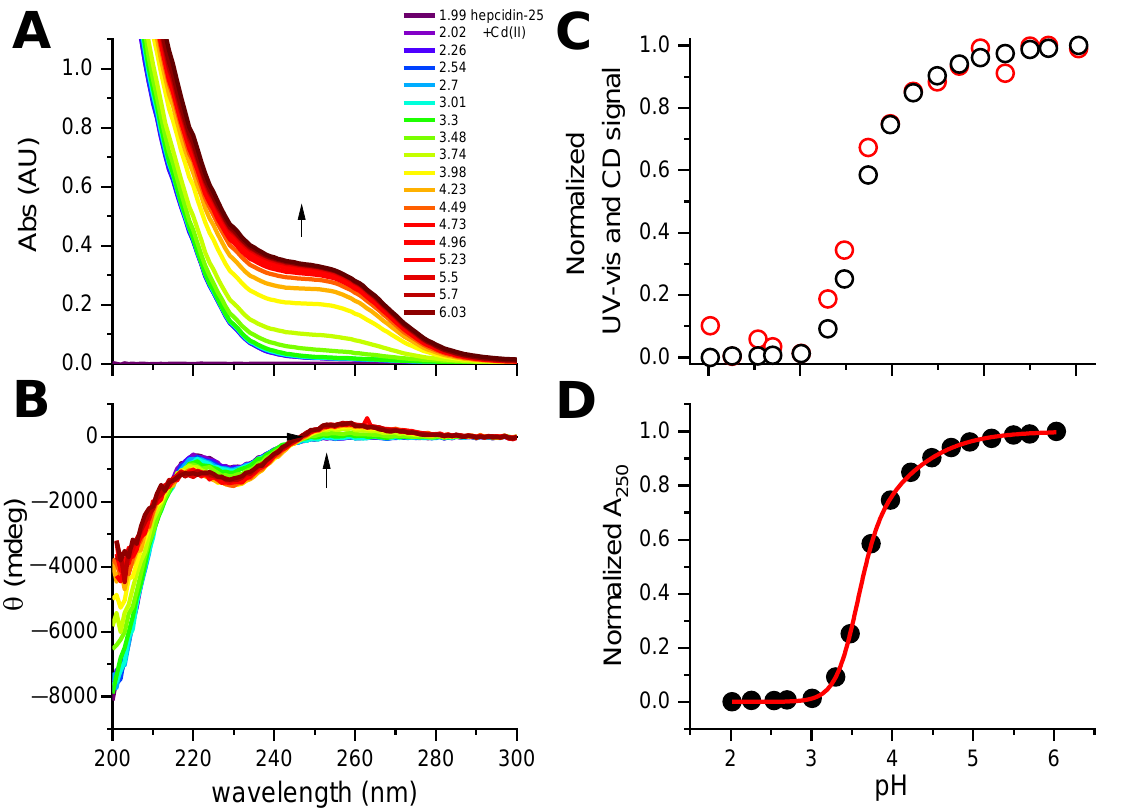
Figure 2. The pH-metric titration of 12.2 µ M hepcidin-25 with 2 eq. of CdCl 2 in the presence of 0.5 mM TCEP. ( A ). UV-vis spectra; ( B ). CD spectra, with the common color codes for pH in plot A; arrows mark the increase of the Cd(II)-S CT bands; ( C ). The pH dependence of CT bands at 250 nm derived from UV-vis (black dots) and CD (red dots) spectra, presented in the common relative scale; ( D ). Fitting of the two-sites binding model to the normalized UV-vis data at 250 nm. The fitting of the titration curve derived from the pH dependence of the Cd(II)-S CT band, presented in Figure 2D, yielded p K exp values for the binding of two Cd(II) ions of 3.60 ± 0.01 and 3.88 ± 0.02. Assuming the average p K of the thiol group (p K SH ) in Hepc-25 as 8.9, by analogy with metallothionein [25], and the structurally equivalent binding of both Cd(II) ions to four Cys residues each, one can tentatively extrapolate these p K values into log K values for absolute Cd(II) affinity constants as high as 21.2 and 20.1, and